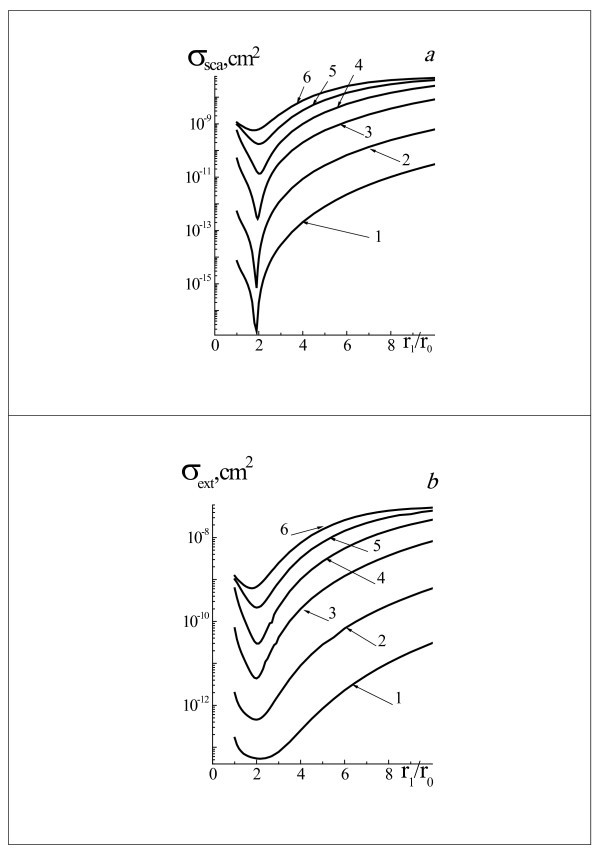
Efficiency cross sections σsca (a) and σext (b) of laser radiation. With wavelength 633 nm by two-layered spherical system gold NP core and water vapor shell for the radii r0 = 10 nm (1), 20 nm (2), 40 nm (3), 60 nm (4), 80 nm (5), and 100 nm (6), and for the range of system radii r1 = (1 ÷ 10) r0.